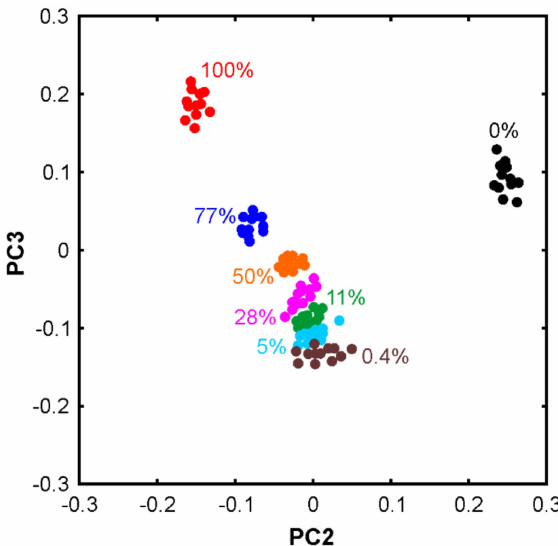
Figure5. Principalcomponentanalysisofthepassionfruitoilblendswithsunfloweroil. Thepercentages indicate the mass fraction of sunflower oil. Variance covered: PC1 (99.9326%), PC2 (0.0151%), and PC3